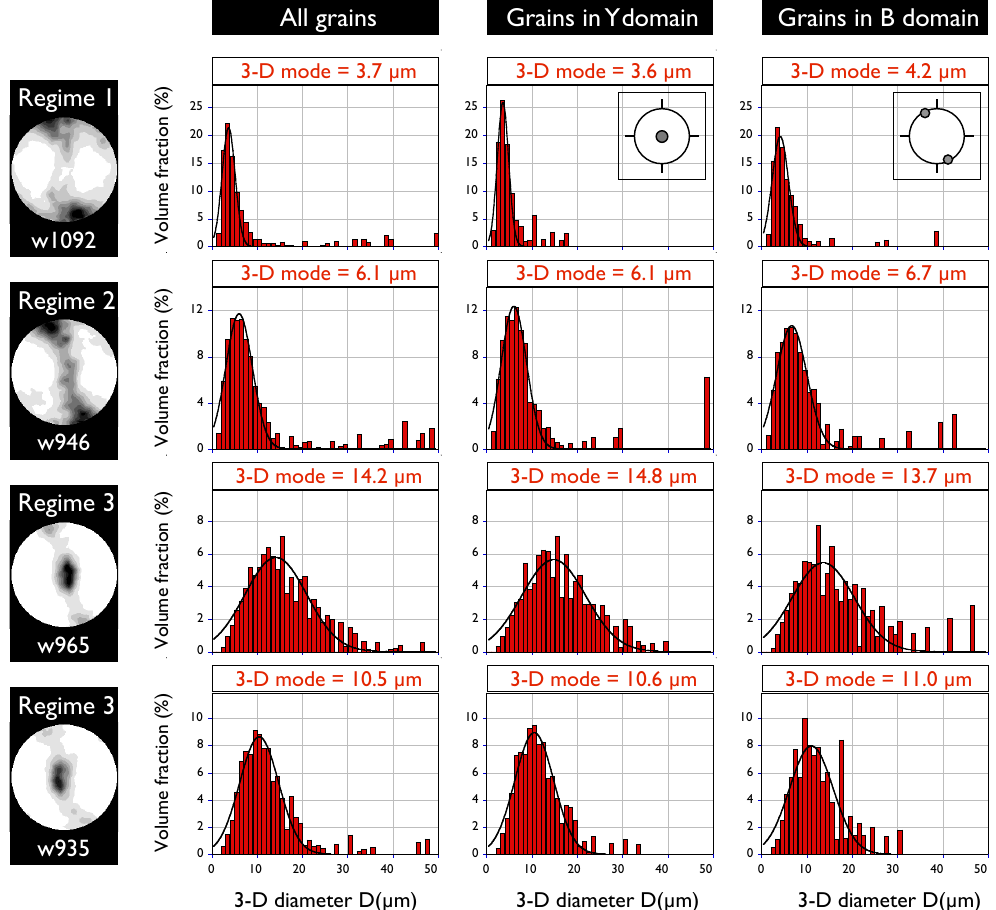
Figure 9. Recrystallized grain size as a function of texture. Grain size distributions of recrystallized grains for four samples of regimes 1, 2, and 3 of dislocation creep, arranged in four rows with c -axis pole figure on the left. From left to right: grain size distributions of all recrystallized grains and those within the Y and B domains. D = diameter of volume equivalent sphere. The mode of v(D) is obtained by a Gauss fit to the distribution. Inset (upper right) schematically shows the location of the corresponding B and Y maxima on the pole